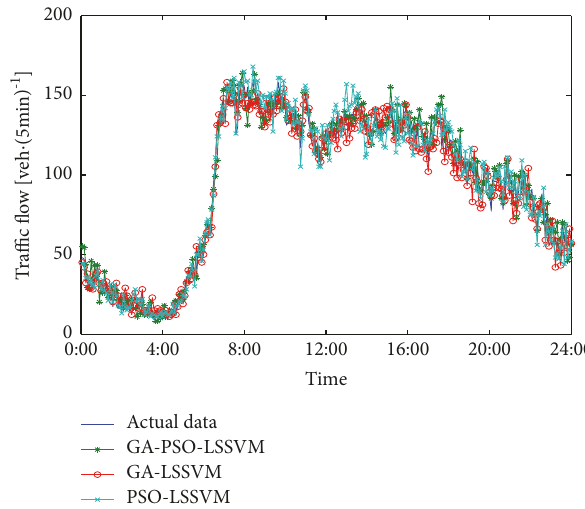
Figure 13: The comparative analysis for detector NBXX15 (2) .